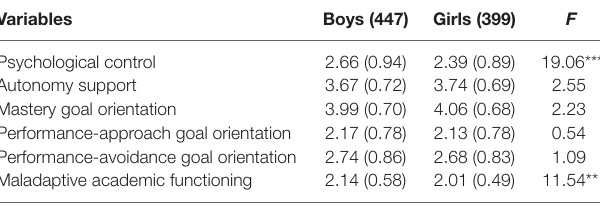
Table 1 | Means and SDs of variables for boys and